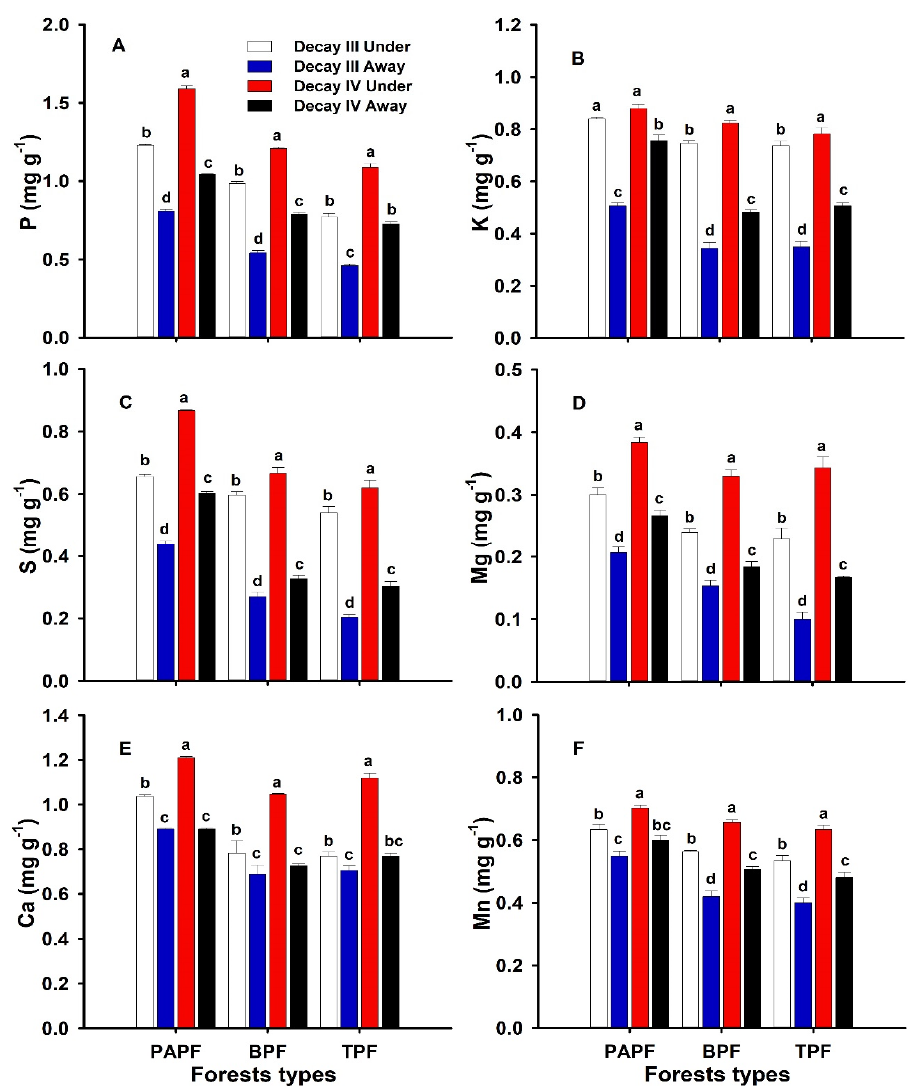
Figure 4. P (mg g − 1 ) ( A ), K (mg g − 1 ) ( B ), S (mg g − 1 ) ( C ), Mg (mg kg − 1 ) ( D ), Ca (mg kg − 1 ) ( E ) and Mn (mg g − 1 ) ( F ) concentrations of the same dominant tree species PK with different decay classes at different distances in contrasting - forest types of PAPF, BPF and TPF in northeastern China. Significant changes between treatments within the same forest type are denoted by various lowercase letters. Tukey’s honest significant difference (HSD) post hoc; p < 0.05, mean ± SE = 3; the bars show standard